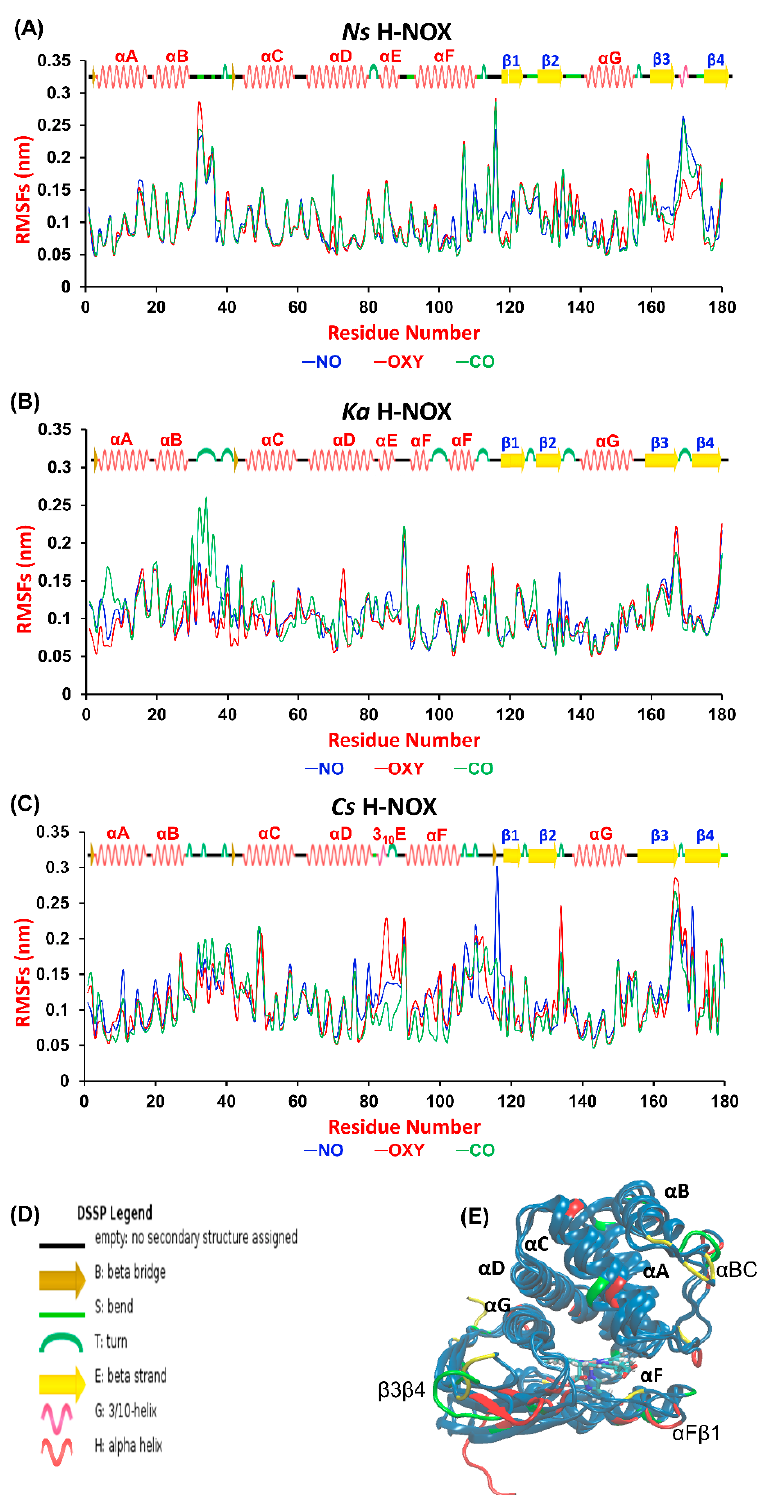
Figure 2. RMSF values computed per-residue from molecular dynamics (MD) simulations of gaseous molecule (NO, CO, O 2 ) di ff usion into ( A ) Nostoc sp. (Ns) , ( B ) Kordia algicida (Ka) and ( C ) Caldanaerobacter subterraneus ( Cs) H-NOX. In the case of Cs , the RMSF values of the long tail (residues 181–188 that are not present in Ns and Ka H-NOX) are not shown to make comparison with other systems easier. ( D ) Labels used for the designation of secondary structure elements by DSPP in Figure 2A–C. ( E ) Superposition of the structure of the three H-NOX proteins. Regions with highest mobility have been highlighted by larger font size, and colored in green ( Ns ), yellow ( Ka ) and red ( Cs ). Molecules 2019 , 24 , x; doi: